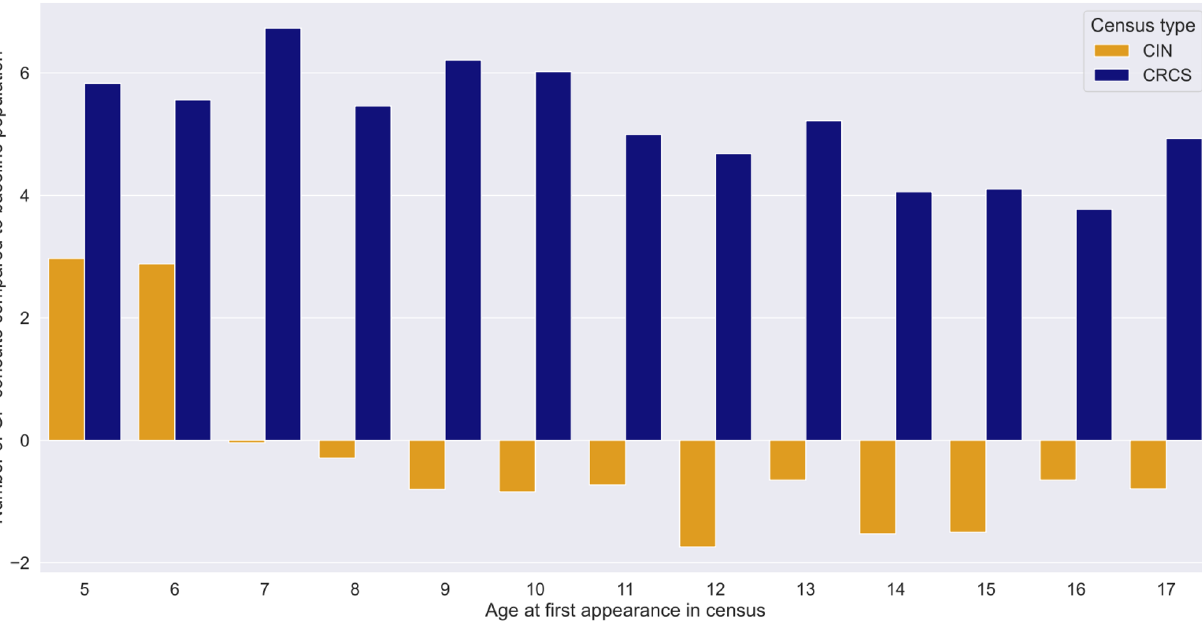
Figure 3: Number of GP consults (visits) for CIN (orange) and CRCS (blue) compared to a baseline